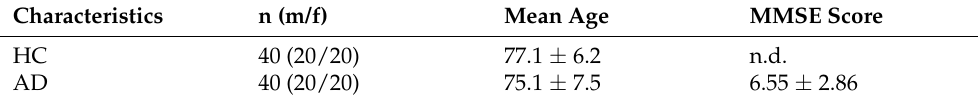
Table 1. Demographic characteristics of the subjects enrolled in this